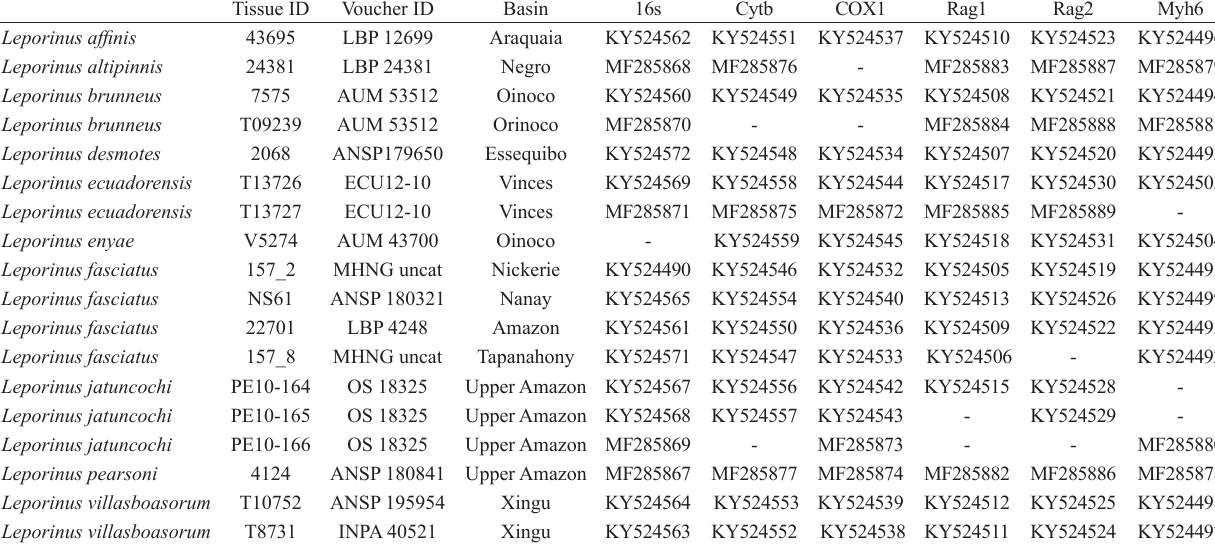
Tab. 1. Voucher and GenBank numbers for tissues used in phylogenetic analysis.